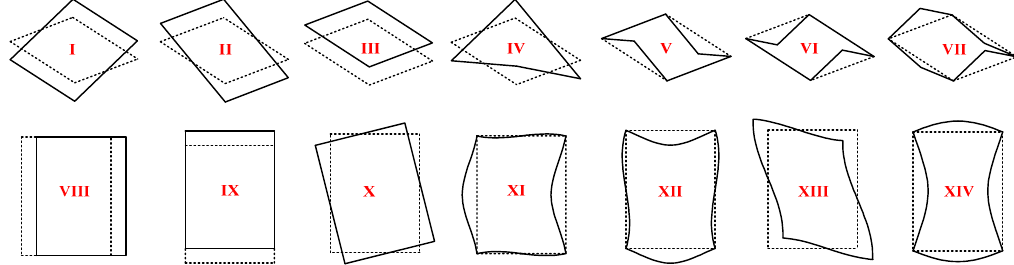
Figure 9. Sectional deformation modes identified from the first 4 modal shapes of the cantilevered thin-walled structure with a rectangular hollow cross-section.